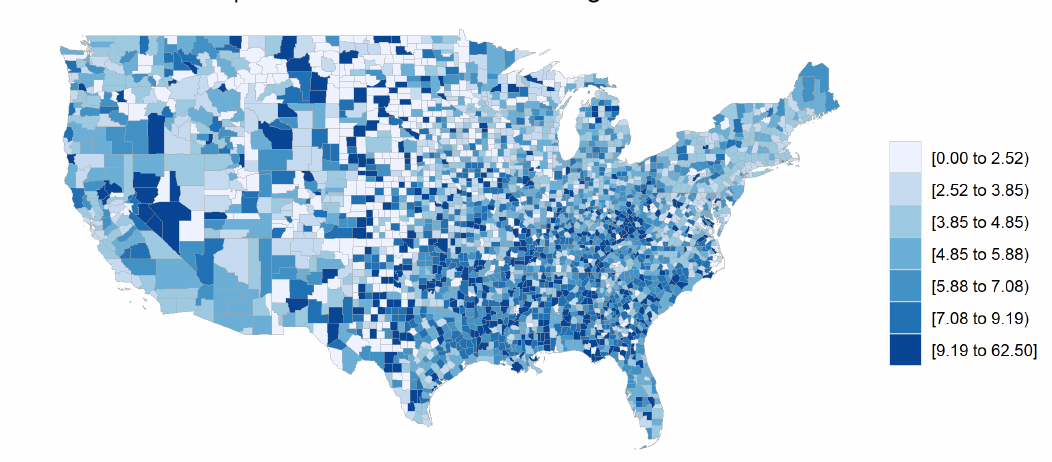
Figure 1. The county-level empirical mortality rates for females ages 55–59 in 2010. The mortality rates are multiplied by 1000 for legibility.